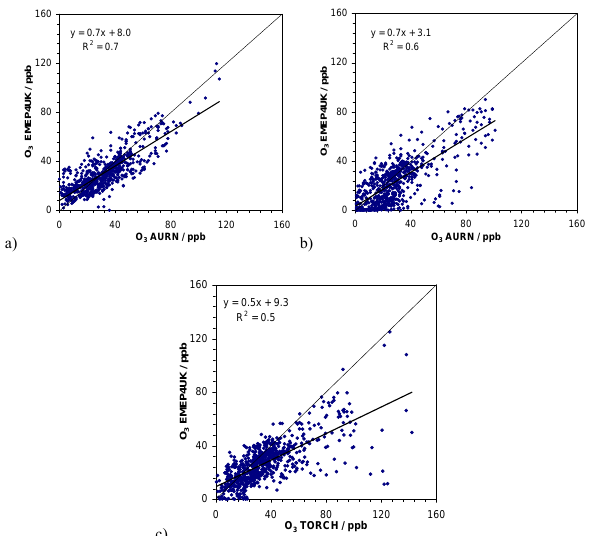
Fig. 5. Scatter plots of modelled vs. observed hourly August 2003 surface ozone (ppb) at (a) Wicken Fen (AURN), (b) London Eltham (AURN), and (c) Writtle (TORCH). The 1:1 line extends to the full scale whereas the best fit line finishes with the maximum modelled or observed value.